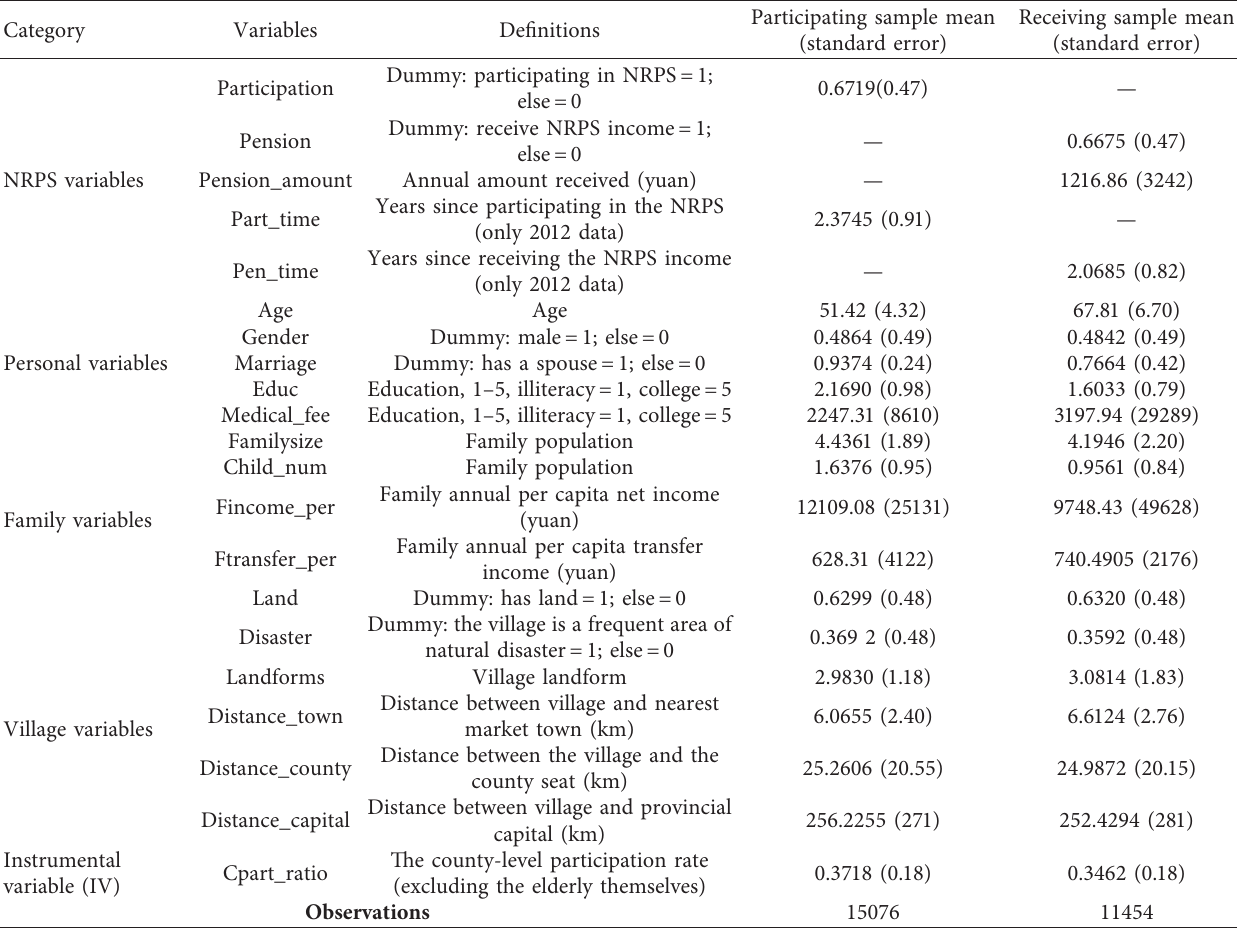
Table 2: Variables definitions and descriptive